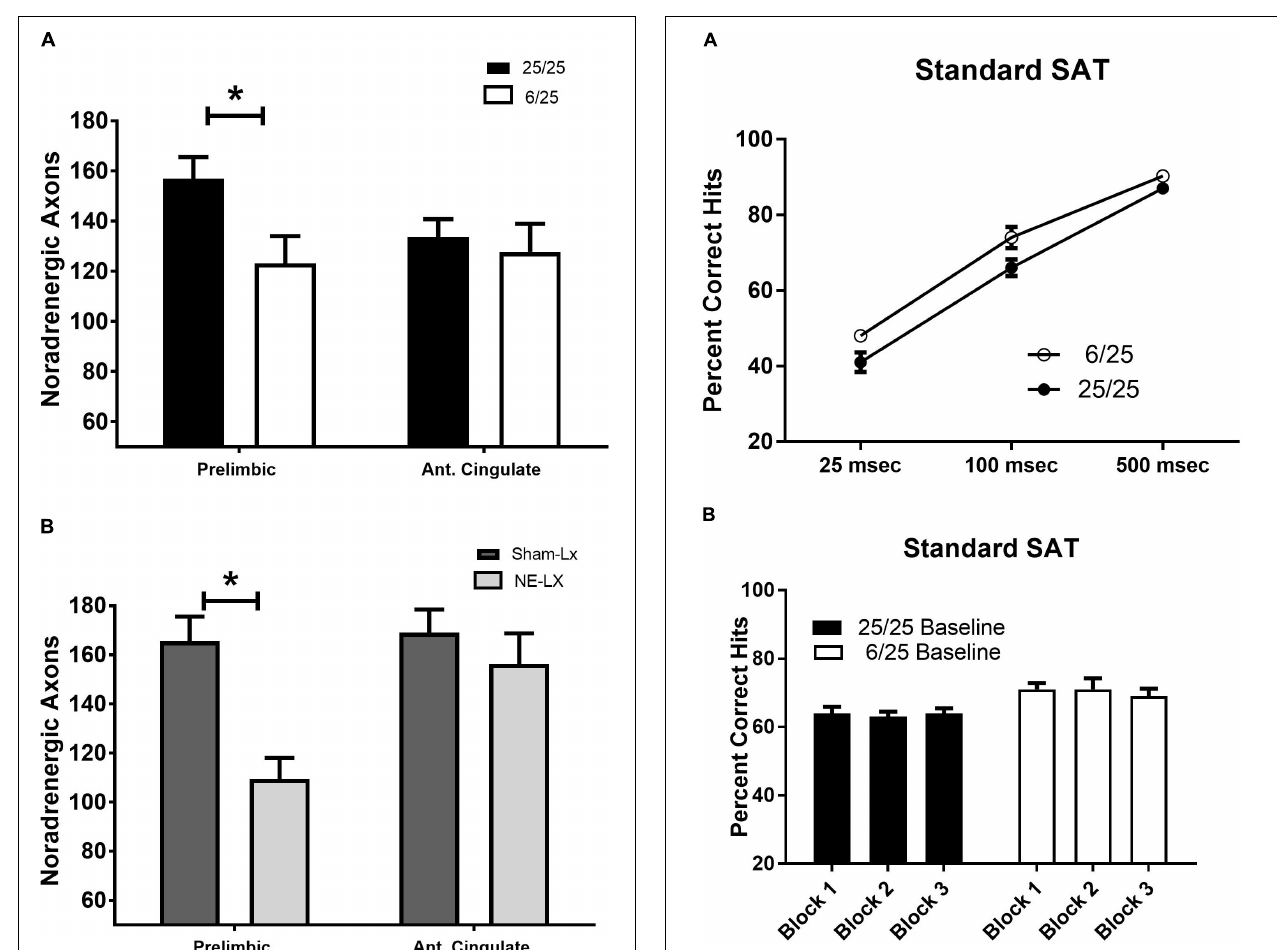
FIGURE 3 | Performance on the baseline SAT task in prenatally well-nourished and malnourished rats. (A) The ordinate shows the percent correct responding to signal trials. The abscissa depicts performance at each stimulus length (25, 100, and 500 ms). When accuracy was averaged across all stimulus lengths, 6/25 (empty circles) rats showed statistically significant higher accuracy on signal trials than controls (25/25; filled circles). Means and SEMs averaged across signal lengths are provided in Table 2 . (B) Blocks of 54 trials are shown on the x -axis. Each block contained 27 signal trials and 27 non-signal trials presented in a pseudorandom order so that each target duration was presented on nine trials. There was no change in performance over the course of the testing session in the SAT for either 6/25 (white bars) or 25/25 rats (black